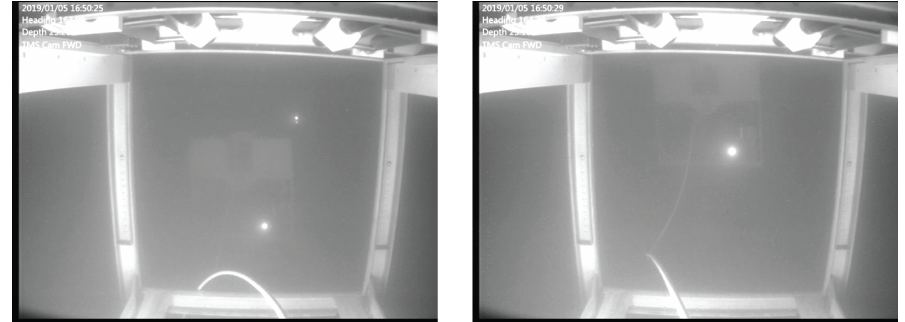
Figure 3. The TMS heaving while ROV holds constant depth. Photo taken during the trials.